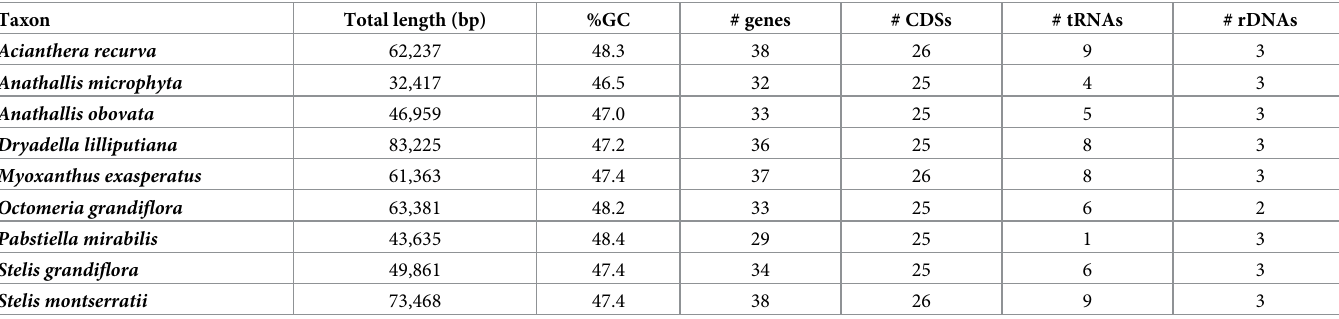
Table 2. General characteristics of mtDNA dataset for Pleurothallidinae.